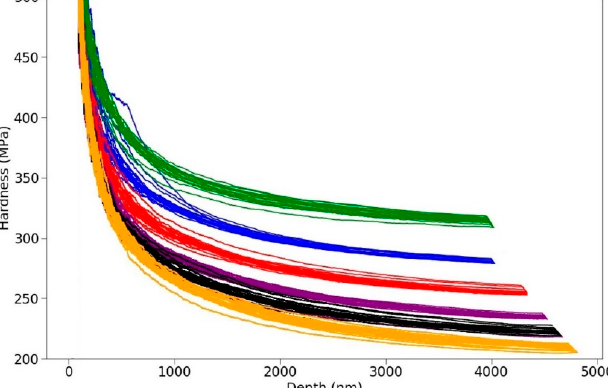
Figure 2. Plot of indentation hardness as a function of depth. The color vs. target strain rate scheme is the same as used in Figure 1. At shallow indentation depths (<1000 nm), a significant size effect can be observed, whereby hardness increases dramatically with decreasing indentation depth, for all target strain rates. At larger indentation depths, the size effect is small, and the hardness approaches a steady-state value corresponding to the given target strain rate.